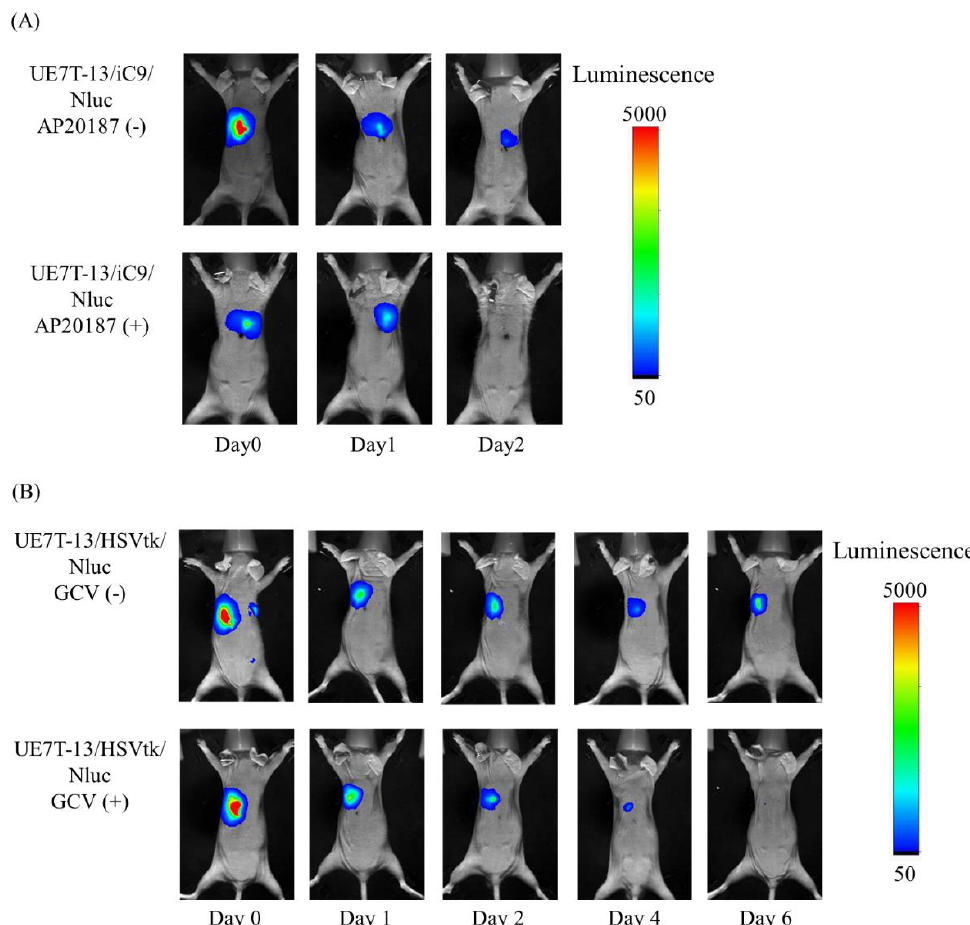
Figure 4. Elimination of UE7T-13 / iC9 / Nluc or UE7T-13 / HSVtk / Nluc cells from mice by AP20187 or GCV, respectively. UE7T-13 / iC9 / Nluc ( A ) or UE7T-13 / HSVtk / Nluc ( B ) cells were subcutaneously transplanted into the back of BALB / c Slc-nu / nu mice. AP20187 (3.7 µ g / kg) was subcutaneously administered twice to UE7T-13 / iC9 / Nluc cell-transplanted mice at a 12 h interval, and GCV (25 mg / kg) was subcutaneously administered to UE7T-13 / HSVtk / Nluc cell-transplanted mice every 12 h for 5 days. The luminescence of the cells transplanted into mice was detected in an In-Vivo Xtreme imaging system. ( − ); without AP20187 or GCV administration, ( + ); with AP20187 or GCV administration.